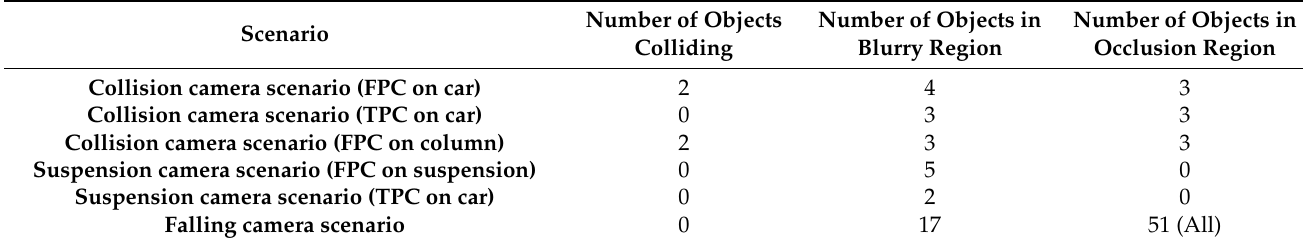
Table 3. Metrics tested for realistic physical camera